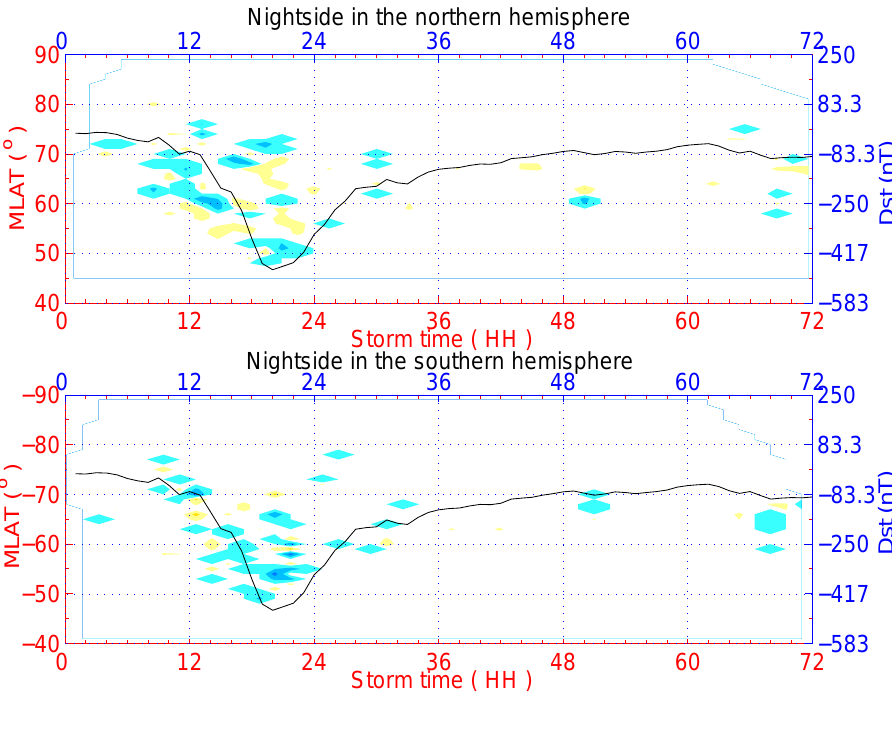
Fig. 9. Same as Fig. 5 but for November event. Table 1. The peak density of FACs at the dayside and nightside in the Northern (Southern) Hemispheres for the October (event 1-1 ∼ 3) and November (event 2)